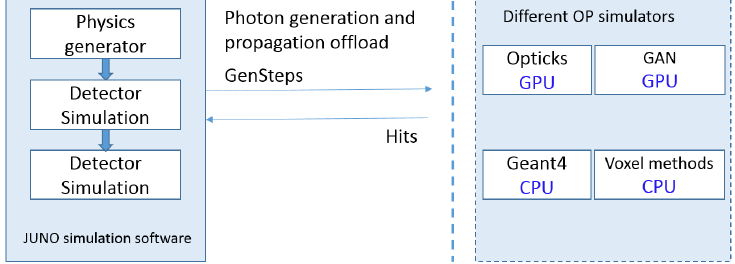
Fig. 6. Deferred optical propagation method to integrate different optical photon